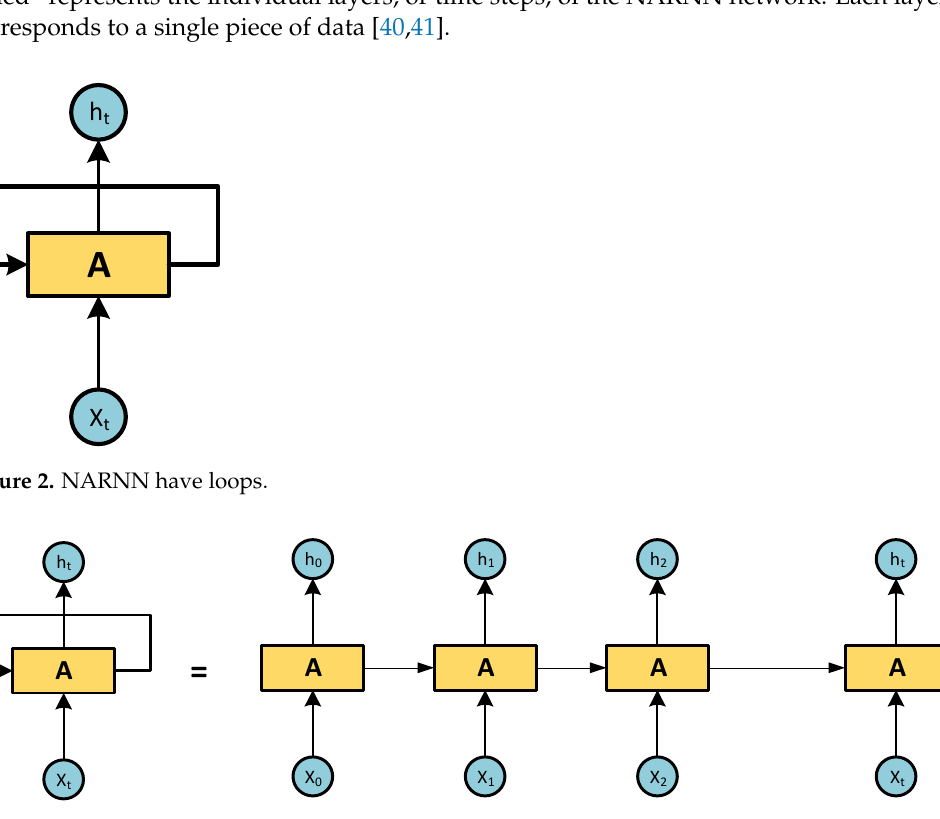
Figure 3. Unrolled NARNN.